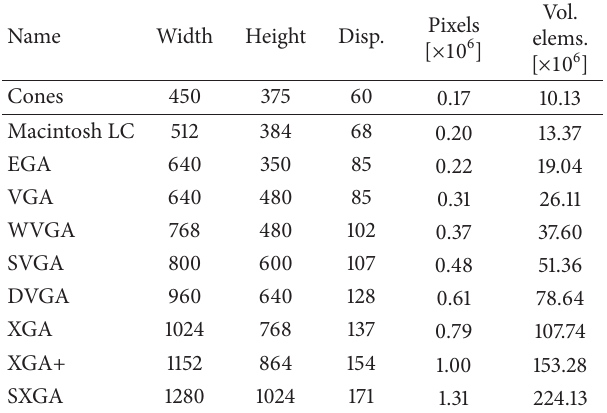
Table 5: Dimensions of high-disparity image series. Figure 12: Low-disparity image series. Speedups of accelerated configurations compared to faster CPU1 . CnyVec versions are at disadvantage because their host parts run on slower CPU2.